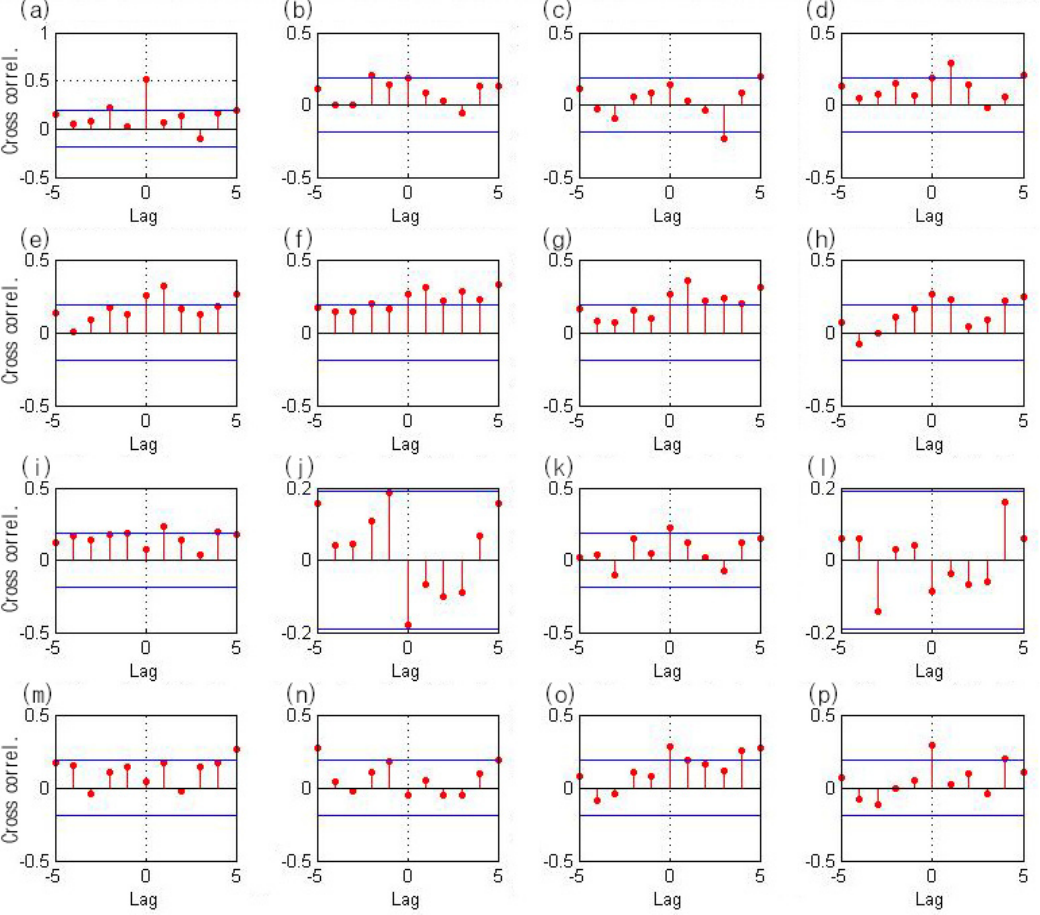
Figure 4. Cross correlation diagram between streamflow and tree ring data at: ( a ) Felkner Ridge; ( b ) Lemon Canyon; ( c ) Calamity Creek; ( d ) Dalton Reservoir; ( e ) Hager Basin Reservoir; ( f ) Antelope Lake (Pinis Jeffreyi Balf.); ( g ) Antelope Lake (Pinus Ponderosa Douglas ex C. Lawson); ( h ) Steens Mountain; ( i ) Hell’s Half Acre; ( j ) Donner Summit; ( k ) Frederick Butte; ( l ) Spring Canyon; ( m ) St. White Mountain; ( n ) Devil’s Dance Floor; ( o ) Sorrel Peak; and ( p ) Piute Mountain.